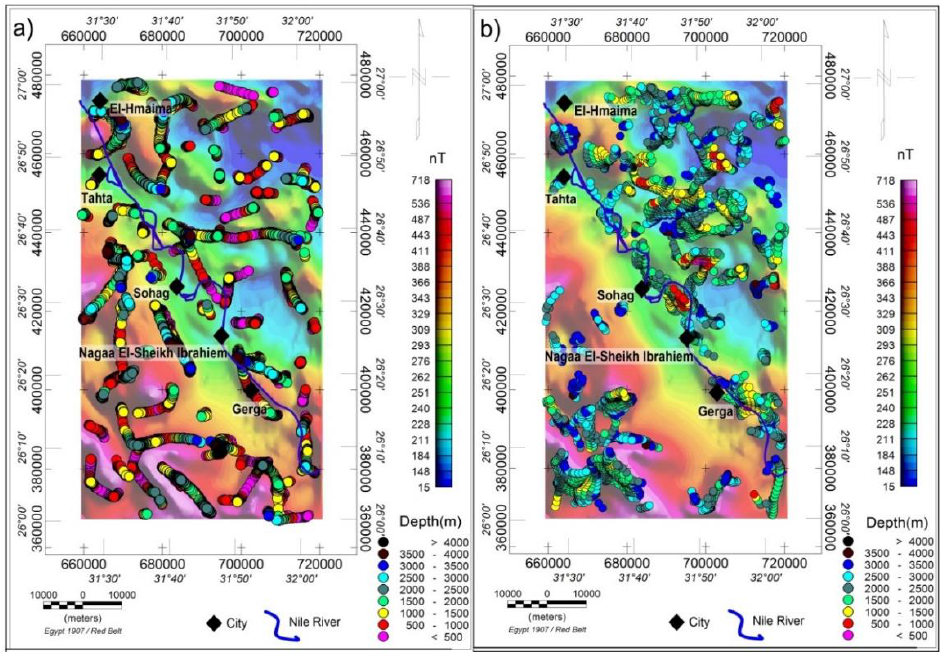
Figure 6. Superposition of the RTP magnetic map and the Euler deconvolution (ED) solutions for ( a ) structural index (SI) = 0 and ( b ) SI = 1.